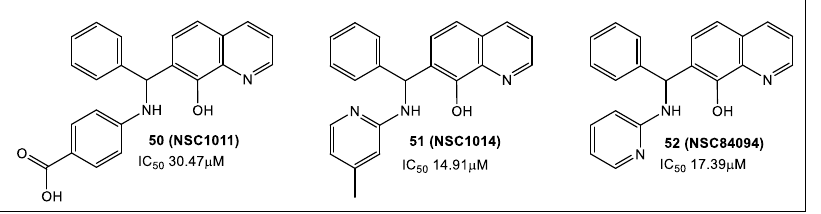
Figure 8. Maximal affinity binding with BoNT/F-LC as shown via SPR was for 51 (NSC1014) (K D : 5.58x10 -6 ). The IC 50 of 50 (NSC1011), 51 (NSC1014), and 52 (NSC84094) were 30.47, 14.91 and 17.39 μM, respectively (endopeptidase assay). Survival times (mouse model) were extended by 50 (NSC1011) and 51 (NSC1014).